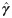
Scenario I. Estimated values of the case fatality (γ^) and case recovery ratios (β^) as computed by least squares using a rolling window.Solid lines correspond to the mean values and dashed lines to lower and upper 90% confidence intervals.